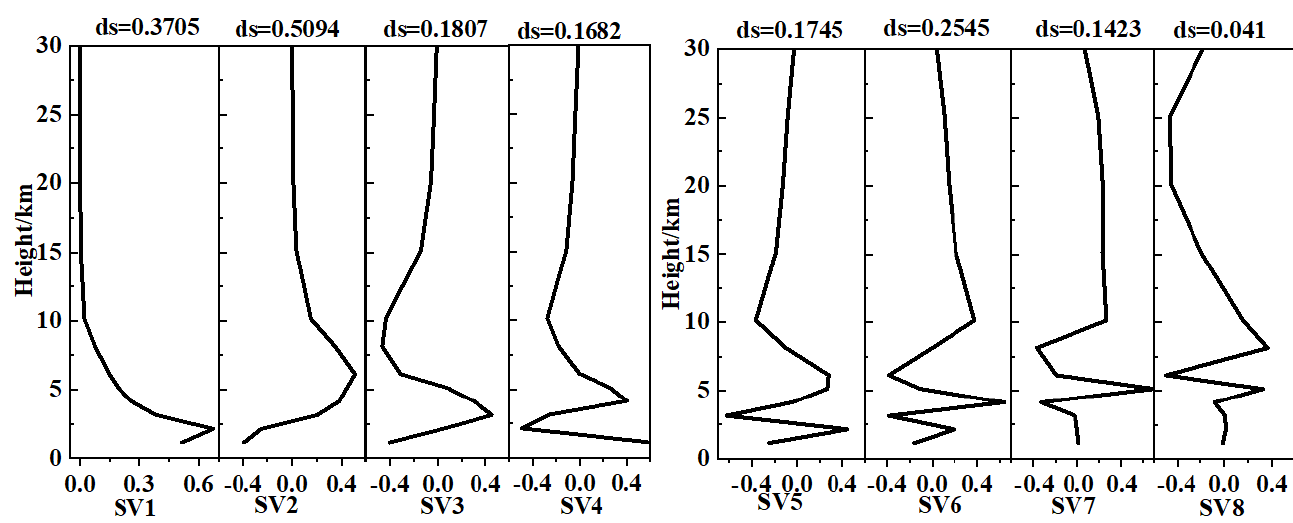
Figure 15. The first eight and most significant singular vectors (SVs) of K (cid:3561) matrix.